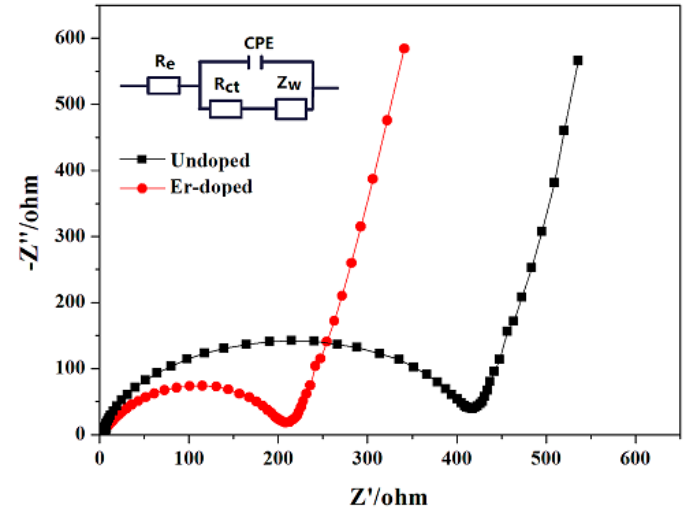
Figure 10. Nyquist plots of the LiNi 0.5 Mn 1.5 O 4 and Er-doped LiNi 0.5 Mn 1.5 O 4 before cycles (the insert is